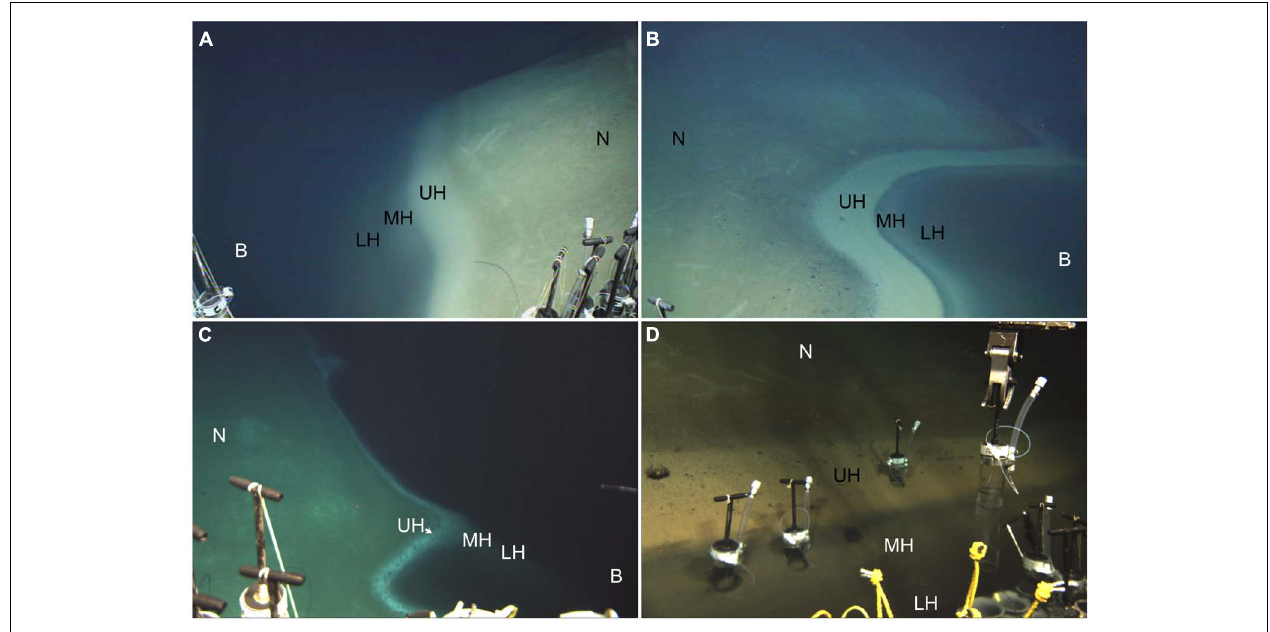
FIGURE 2 | Underwater photographs showing small portion of redoxcline impinging the seafloor in Urania (A), Discovery (B,D), and L’Atalante (C) DHABs, eastern Mediterranean. Note red laser spots on seafloor in (C) ; dots are spaced 10 cm apart. N = normoxic control region;